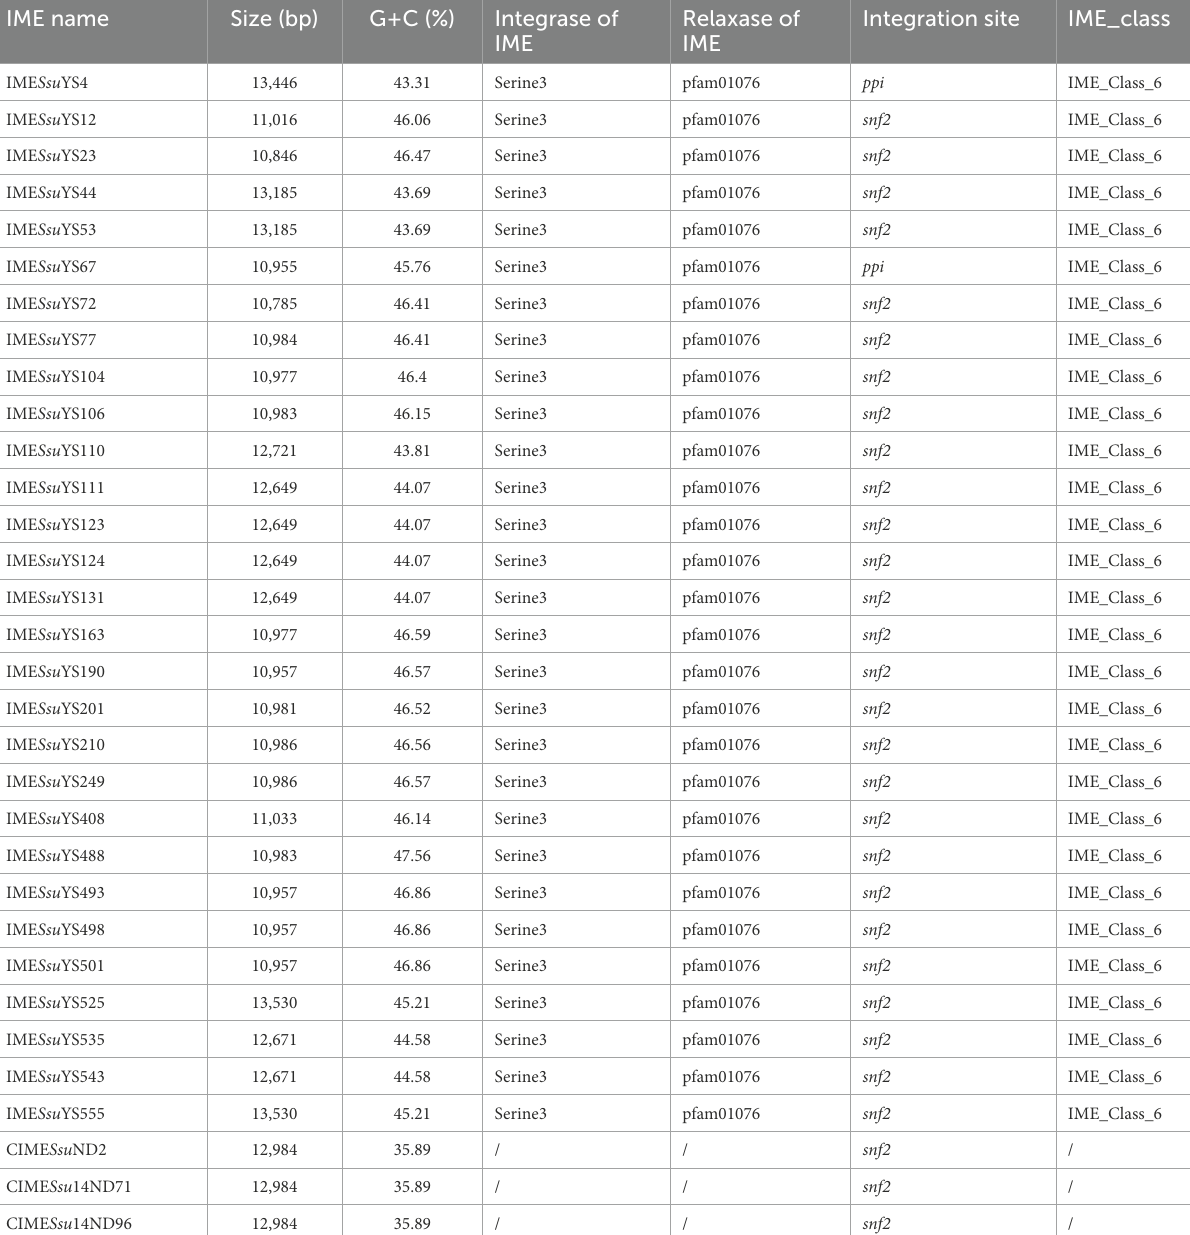
TABLE 2 Characteristics of IMEs and CIMEs identified in the present study. IME